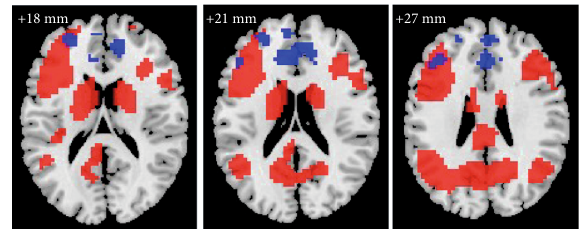
Figure 4: Brain regions activated in item memory before anodal transcranial direct current stimulation (atDCS) (red color) and showing signi fi cant Group × Test time interactions after atDCS (blue color). Overlap is present in the left middle frontal gyrus.